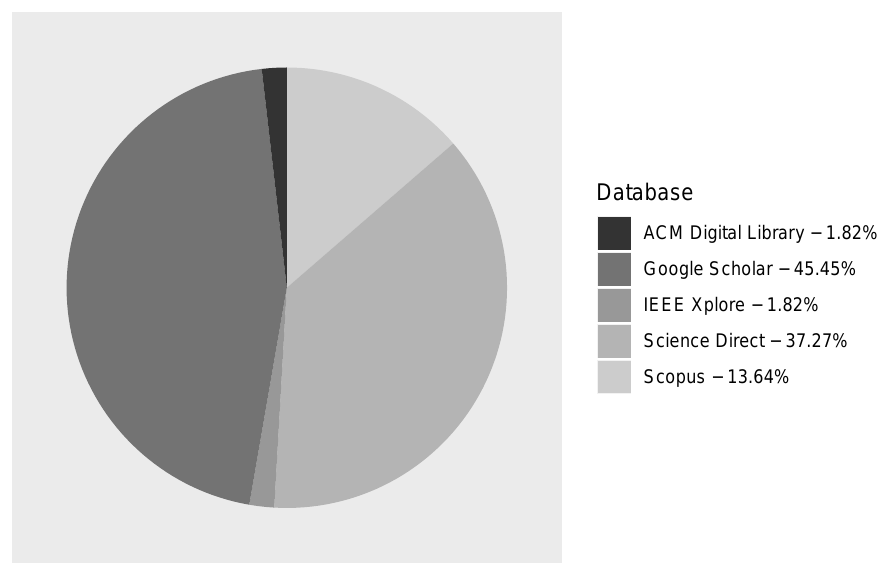
Figure 2. Percentage of the selected primary study per database. (Authors’ own).